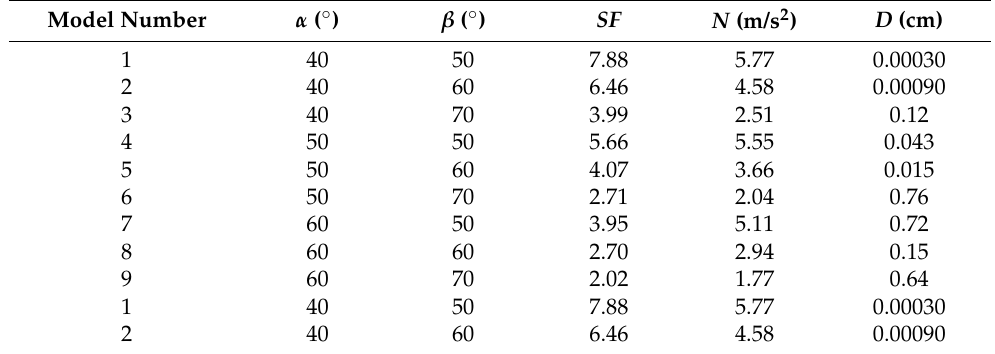
Table 2. Model-related parameters and permanent displacements calculated using Newmark’s